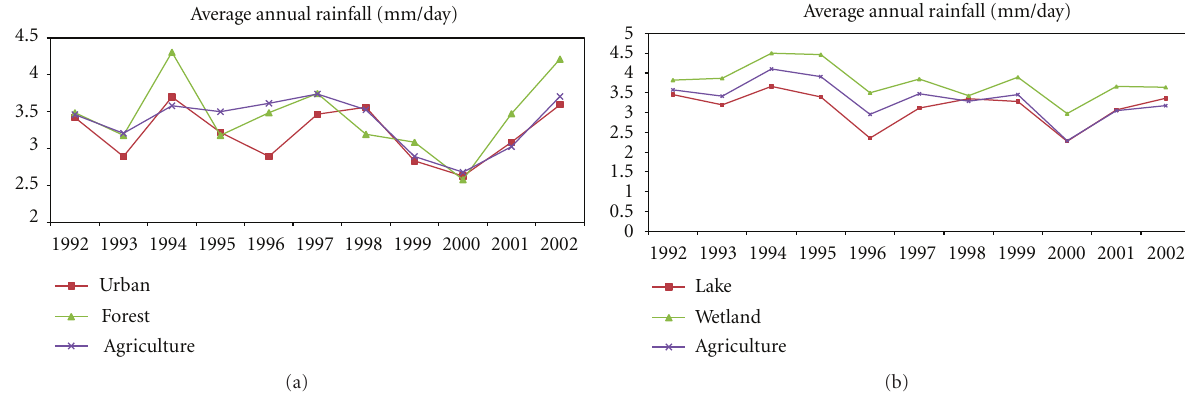
Figure 3: Six selected 32 × 32km 2 regional study areas along with land use/land cover from the 2001 National Land Cover Dataset.